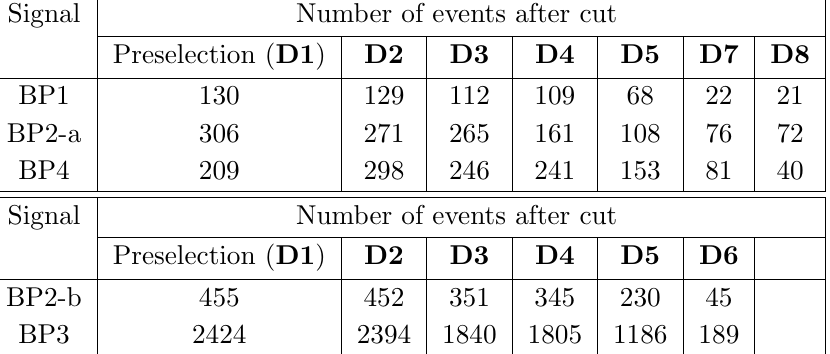
Table 9 . Opposite Sign di-lepton + =E (cid:12)nal state number of events at 100 fb (cid:0) 1 for SUSY signals. T Note that the events have been rounded-o(cid:11) to the nearest integer. Cross-sections have been scaled using NLO K-factors obtained from Prospino .